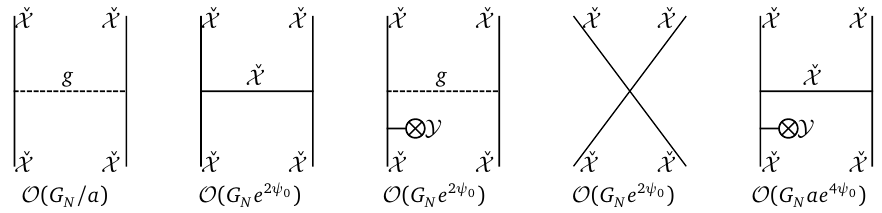
Figure 2: Leading (tree level) diagrams contributing to the four-point function. The second, third and fourth diagrams enter at the same order, and they give the next leading correction to the gravitational backreaction. Notice that the fourth diagram is due to a quartic